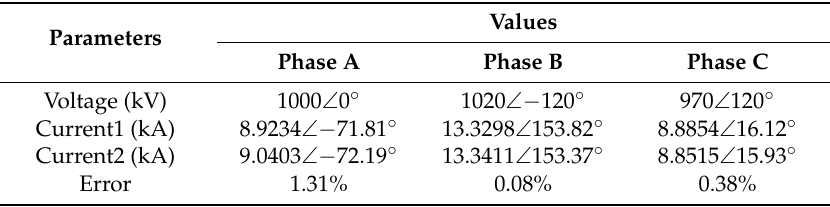
Table 3. Measured currents at the first group of voltages.